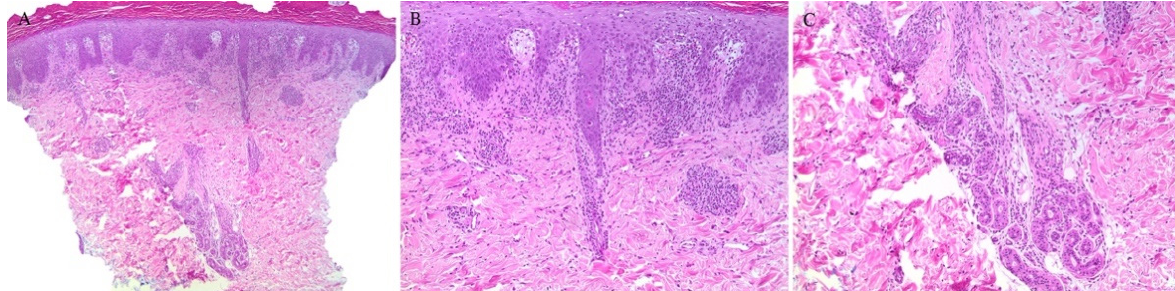
Figure 7. ( A – C ) Pityriasis lichenoides et varioliformis acuta with perieccrine inflammation.